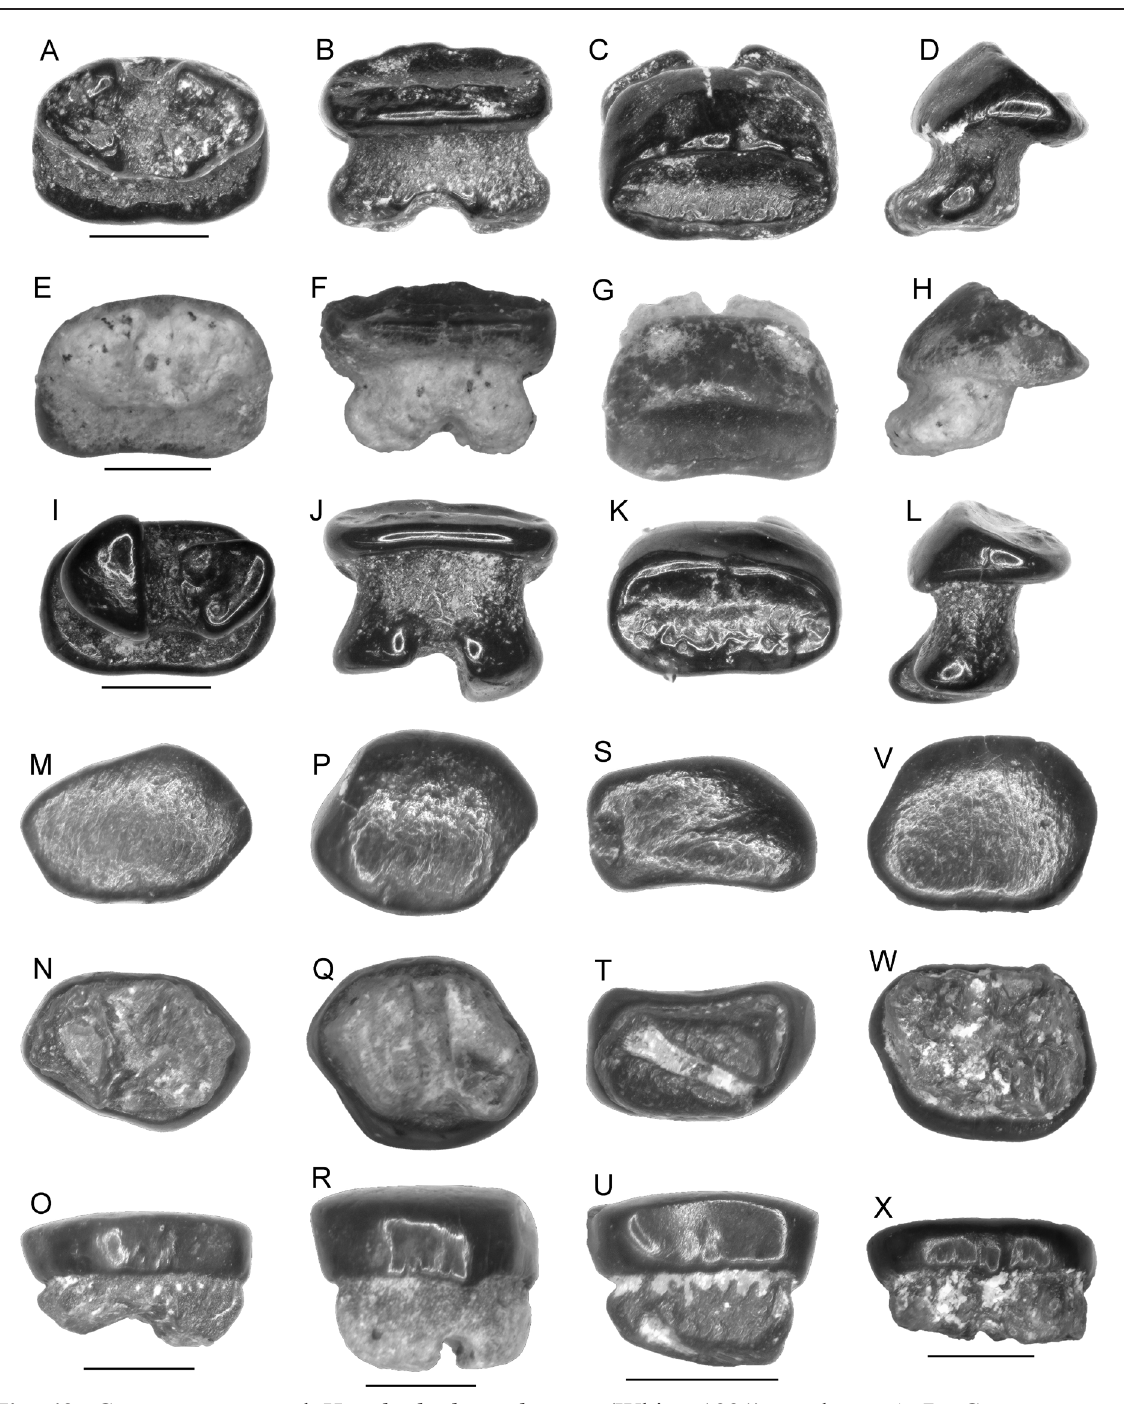
Fig. 42. Coupatezia sp. and Hypolophodon s ylvestris (White, 1931), teeth. — A–L . Coupatezia sp. A–D . MSC 37339, basal Lisbon Formation. A . Basal view. B . Basiolabial view. C . Oral view. D .